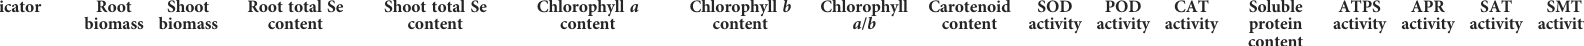
TABLE 3 Correlations among the biomass, total Se content, photosynthetic pigment content, antioxidant enzyme activity, soluble protein content, and Se metabolism-related enzyme activity. Indicator